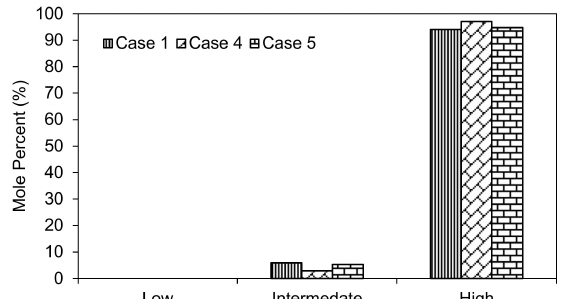
Figure 7. Remaining oil composition of CO 2 -acetone mixture injection based on carbon number clas- sification.